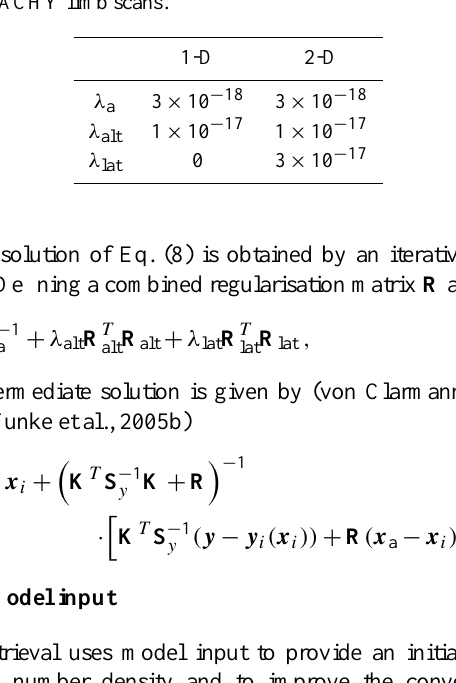
Table 3. Regularisation parameters as used in the NO retrieval from SCIAMACHY limb scans.